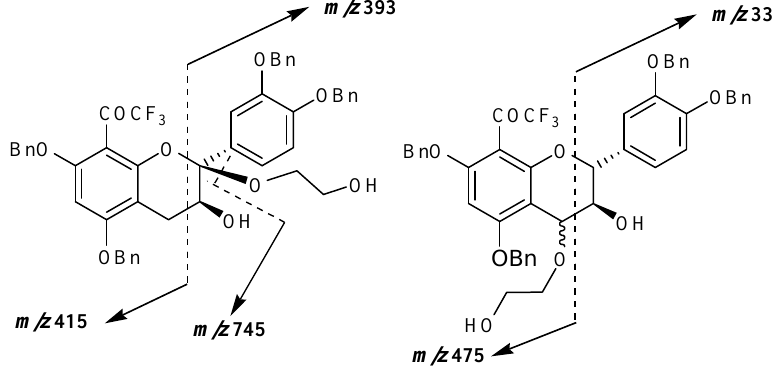
Figure 4. Main fragmentations observed in compounds 20a , 20b and 20c